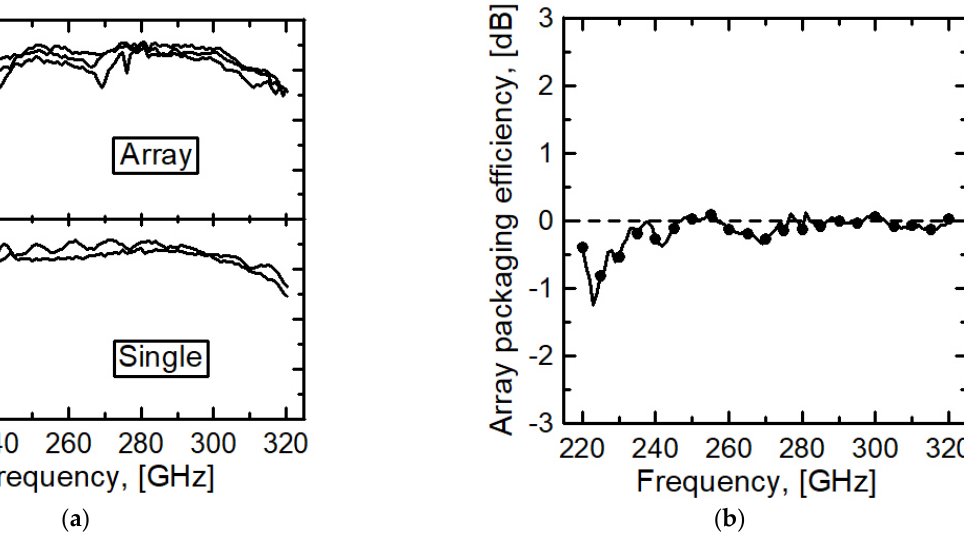
Figure 3. Measured array module performance. ( a ) Insertion loss comparison with the single-element modules; ( b ) average loss difference from the single-element modules.